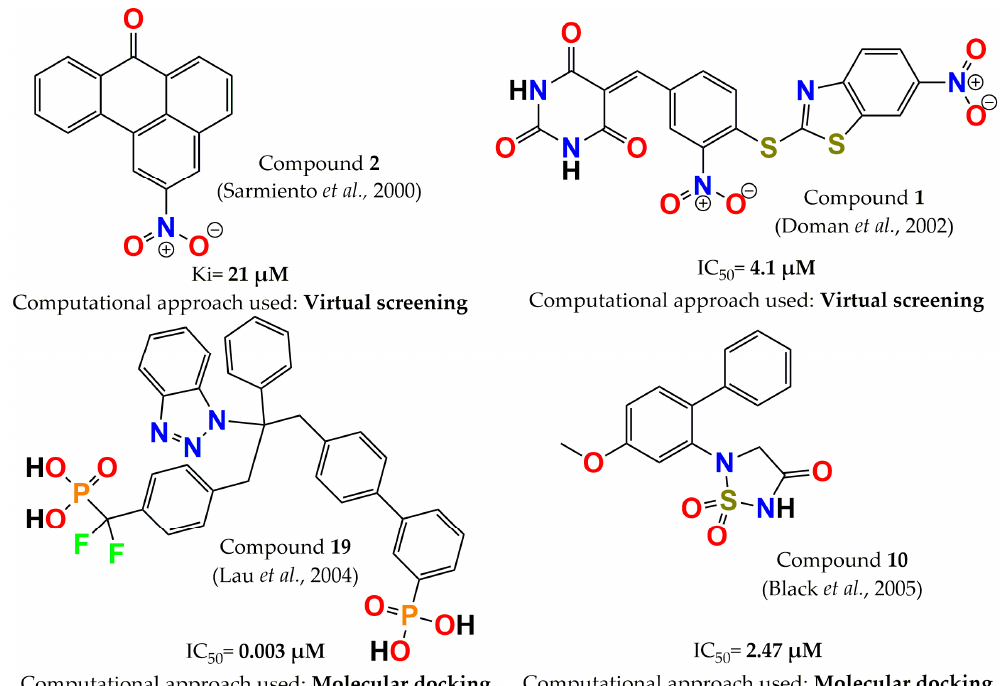
Figure 3. Structure of the most potent PTP1B inhibitors reported between 2000 and 2005 discovered through computational approaches.